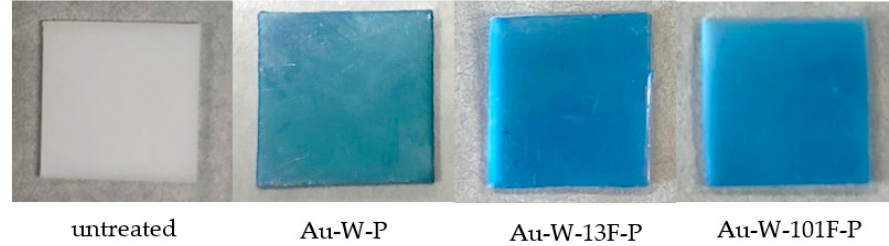
Figure 8. Photographs of dye staining of various PTFE samples with methylene blue.